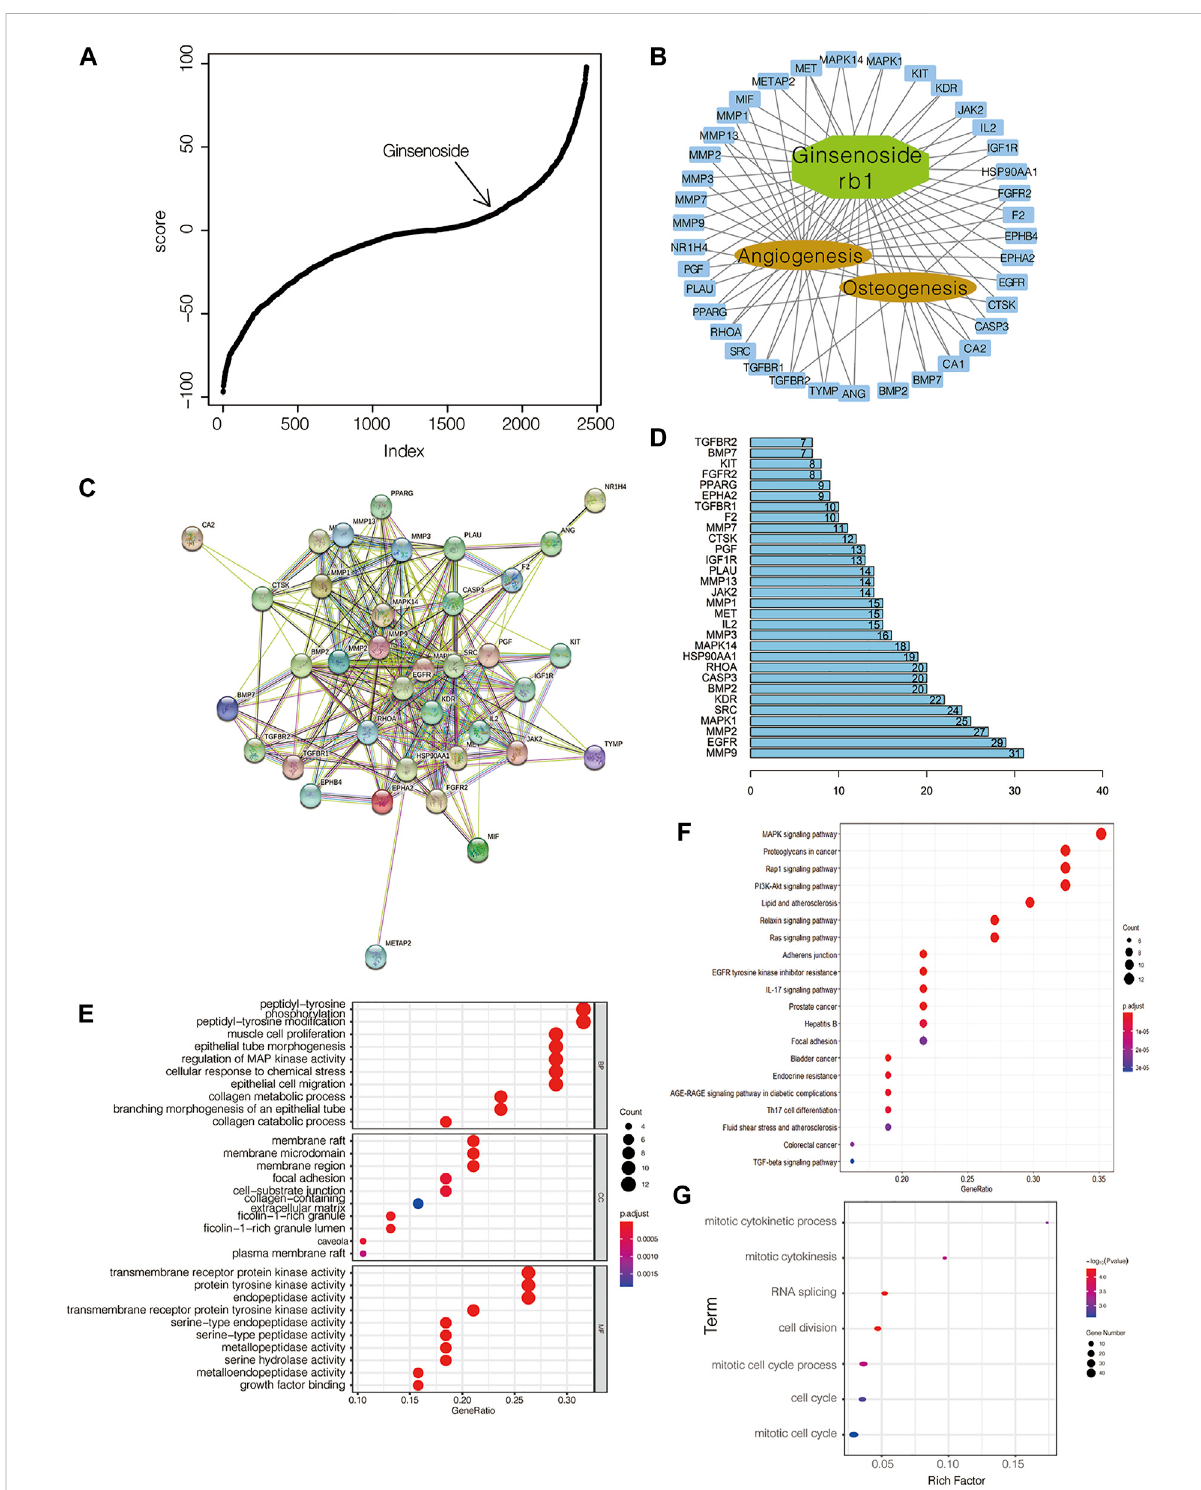
FIGURE 3 Identi fi cationofginsenosideRb1asanosteogeniccompound. (A) GinsenosideRb1isinvolvedinCMap-basedmolecularscreeningresultsfrom the icariin-induced gene expression signature; (B) network between ginsenoside Rb1-targeted genes and those related to osteogenesis and angiogenesis; (C) PPIbetweenginsenosideRb1-targetedgenesandthoserelatedtoosteogenesisandangiogenesis; (D) hubgenesinC;numberson the bar and the edge number of the corresponding gene in C; (E) GO-based and (F) KEGG-based gene set enrichment analyses of genes in B; (G) GO-based gene set enrichment analysis of differentially expressed genes in BMSCs administered with ginsenoside Rb1 at 20 μ M after 24 h